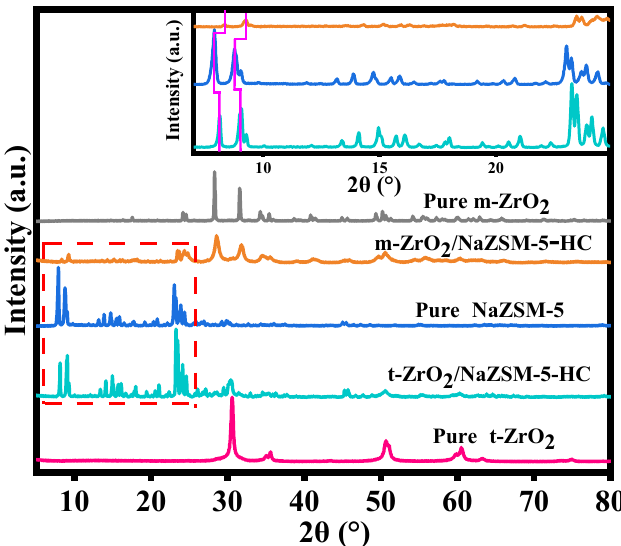
Figure 2. XRD patterns of different catalysts.